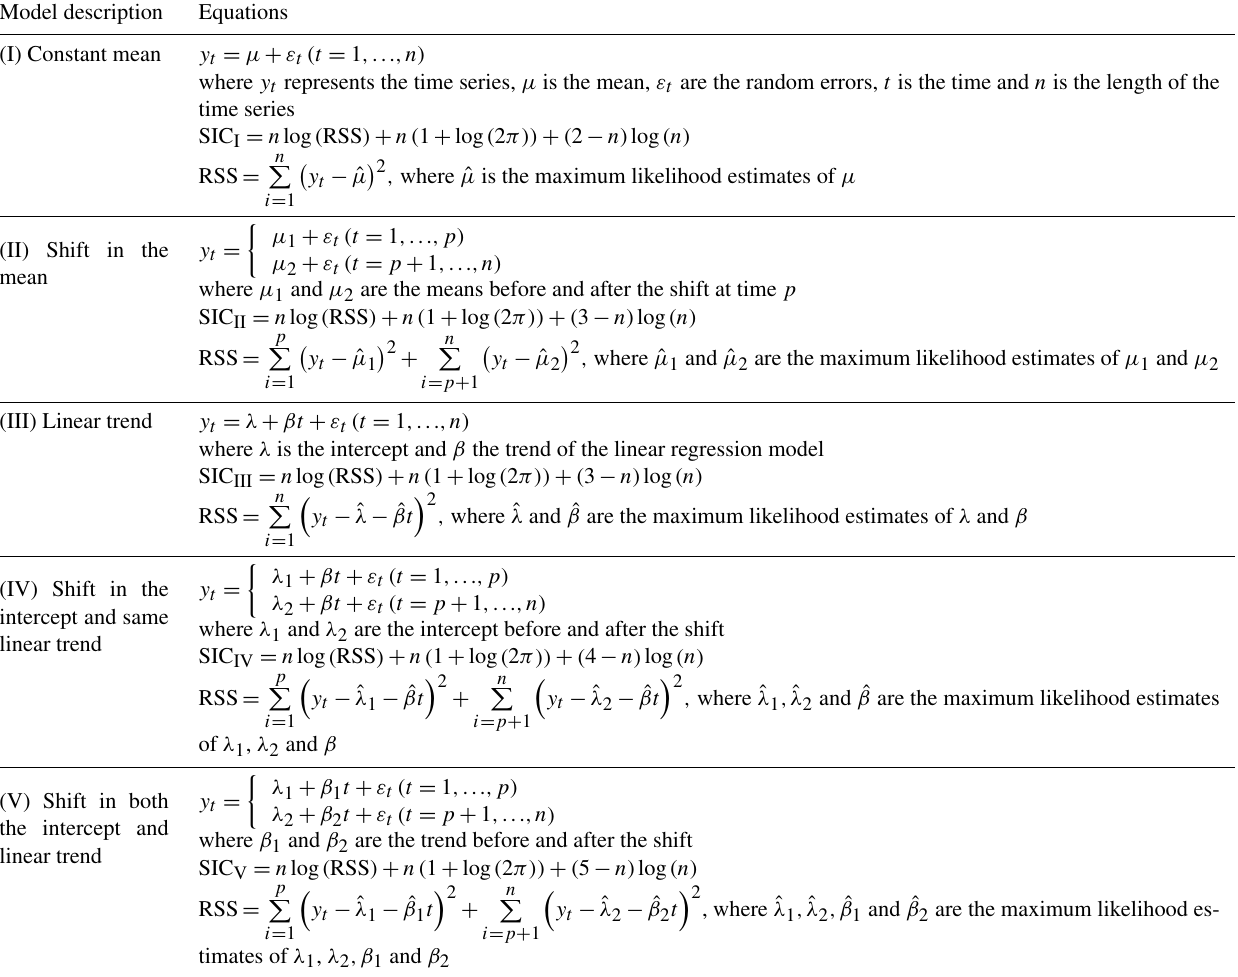
Table 2. List of models fitted in this study with their associated Schwarz Information Criterion (SIC) formulation. Model description